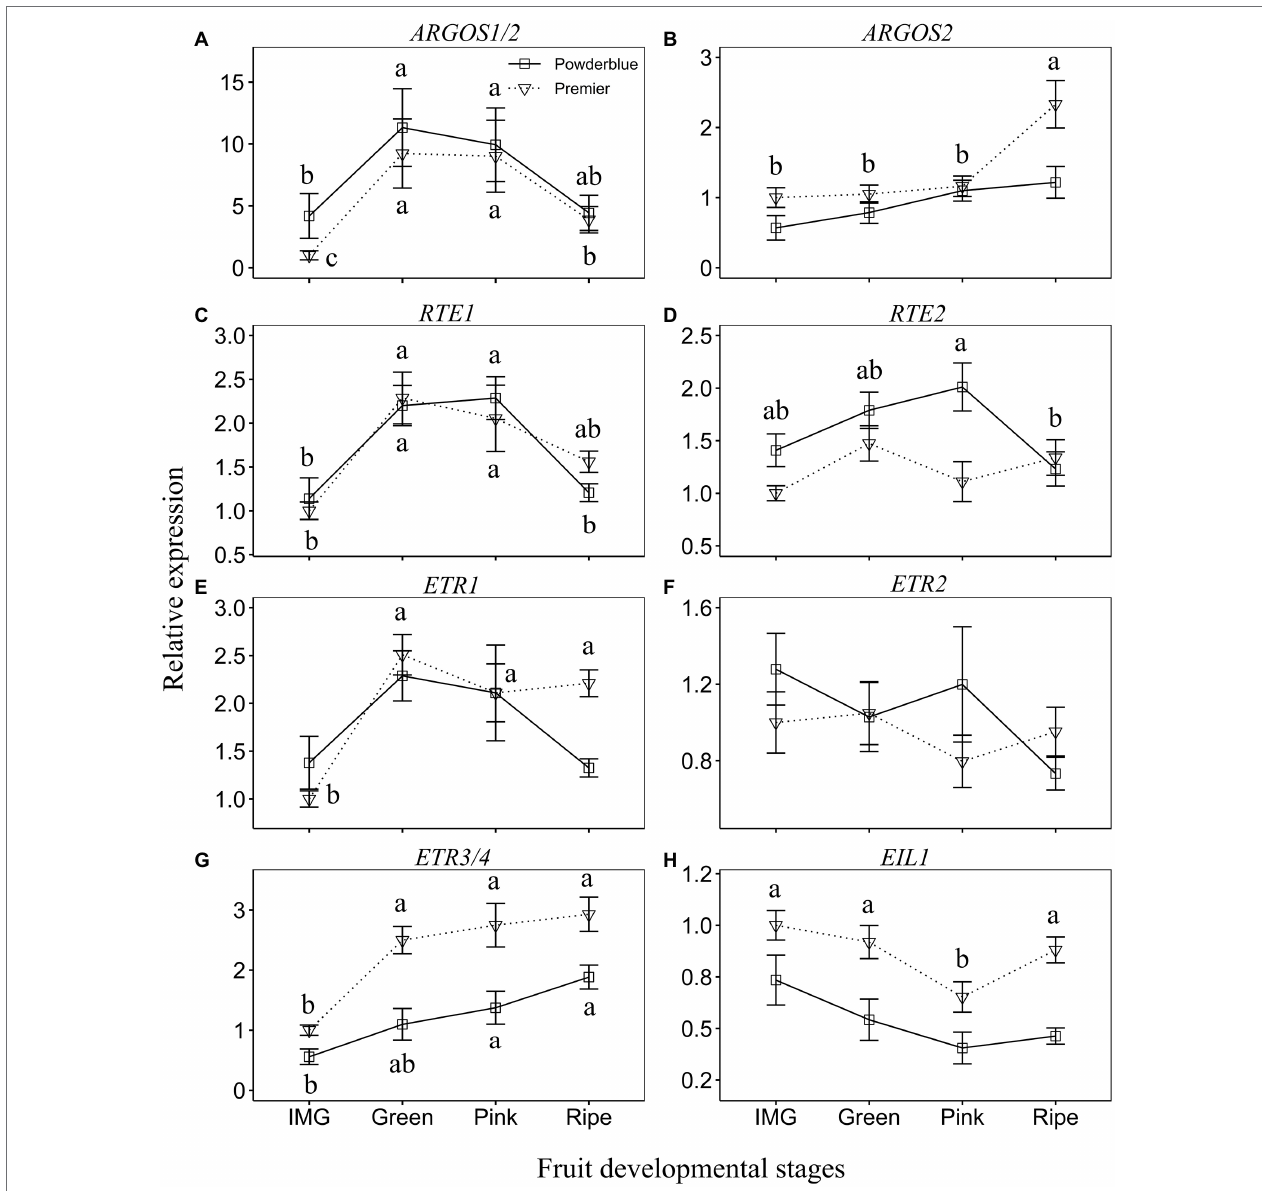
FIGURE 5 | Transcript abundance of ethylene signaling genes during fruit development. (A) ARGOS1/2 , (B) ARGOS2 , (C) RTE1 , (D) RTE2 , (E) ETR1 , (F) ETR2 , (G) ETR3/4 , and (H) EIL1 . ARGOS: AUXIN REGULATED GENE INVOLVED IN ORGAN SIZE; RTE: REVERSION TO ETHYLENE SENSITIVITY; ETR: ETHYLENE RECEPTOR; EIL1: ETHYLENE INSENSITIVE 3 – LIKE1 . The different letters indicate the means are significantly different across fruit developmental stages within a given cultivar according to ANOVA and Tukey’s HSD ( α =